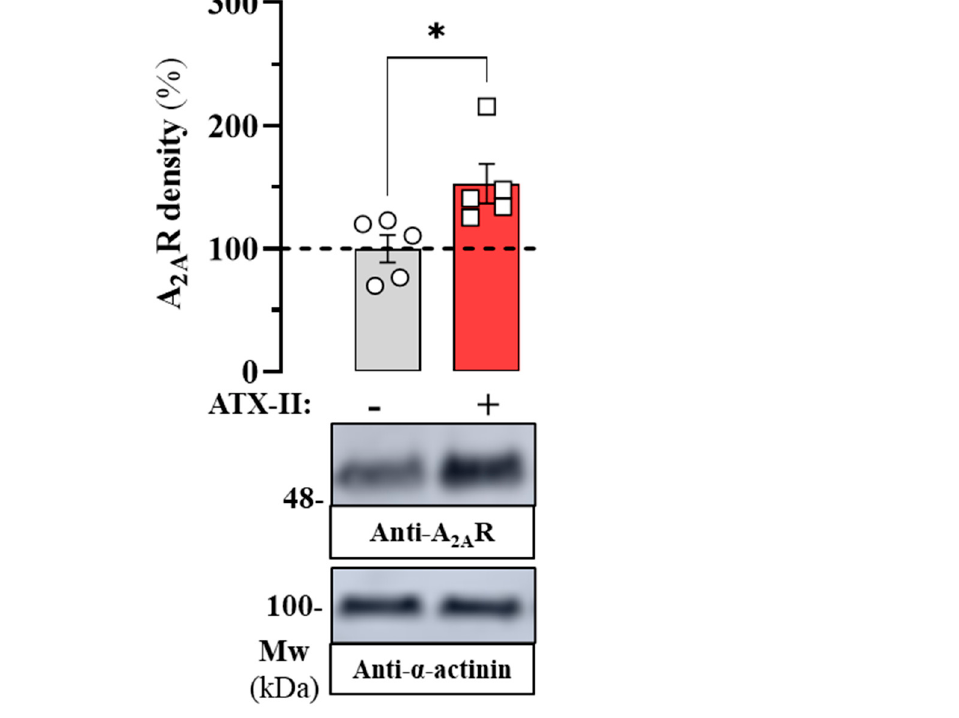
Figure 2. Effect of ATX-II on the density of A 2A R in HL-1 cells. HL-1 cells were incubated in the absence (circles in grey colum) or presence of ATX-II (30 nM) (squares in redcolumn) for 24 h before membrane extracts were analysed by SDS-PAGE (20 µ g of protein/lane) and immunoblotted using mouse anti-A 2A R and rabbit anti- α -actinin antibodies. A representative immunoblot is shown (lower panel). Immunoblot protein bands corresponding to A 2A R and α -actinin from vehicle ( n = 5) and ATX-II ( n = 5) treated cells were quantified by densitometric scanning. Values were normalized to the respective amount of α -actinin in each lane to correct for protein loading. The results are shown as percentage of the relative density of A 2A R in cells treated with saline (ATX-II -; dashed lane) and expressed as mean ± SEM ( n = 5). * p < 0.05, Student’s t -test.